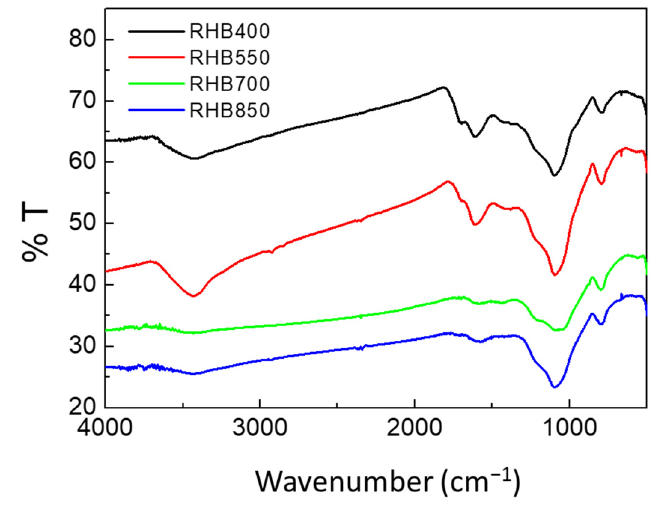
Figure 3. Fourier-transform infrared (FTIR) spectra of the biochars studied.